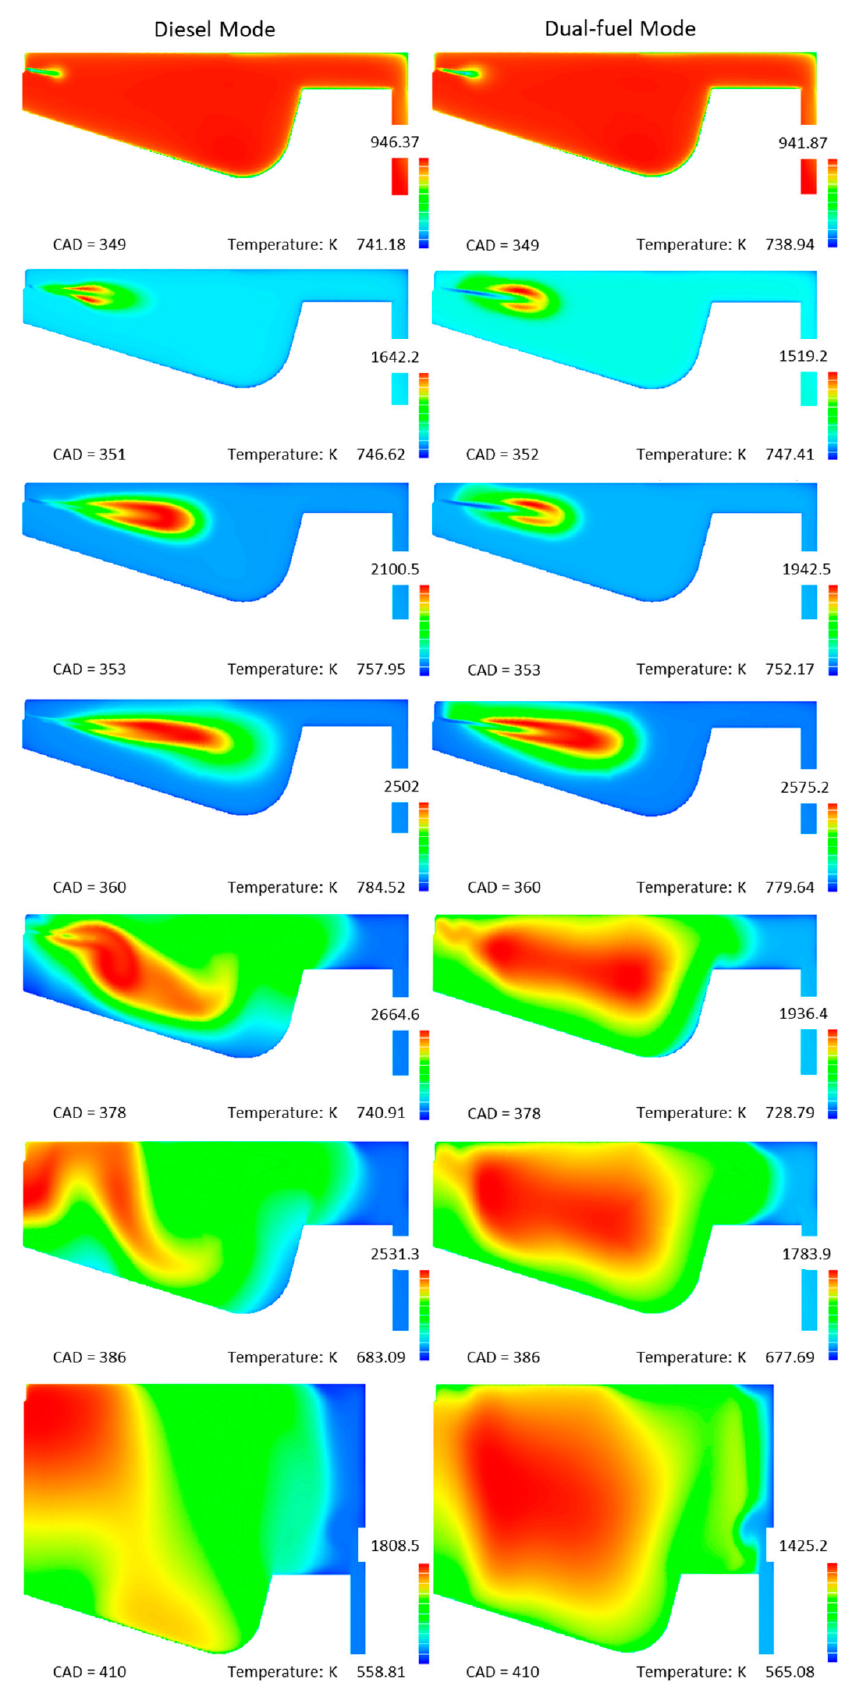
Figure 18. The spatial in-cylinder temperature contours at some crank angle